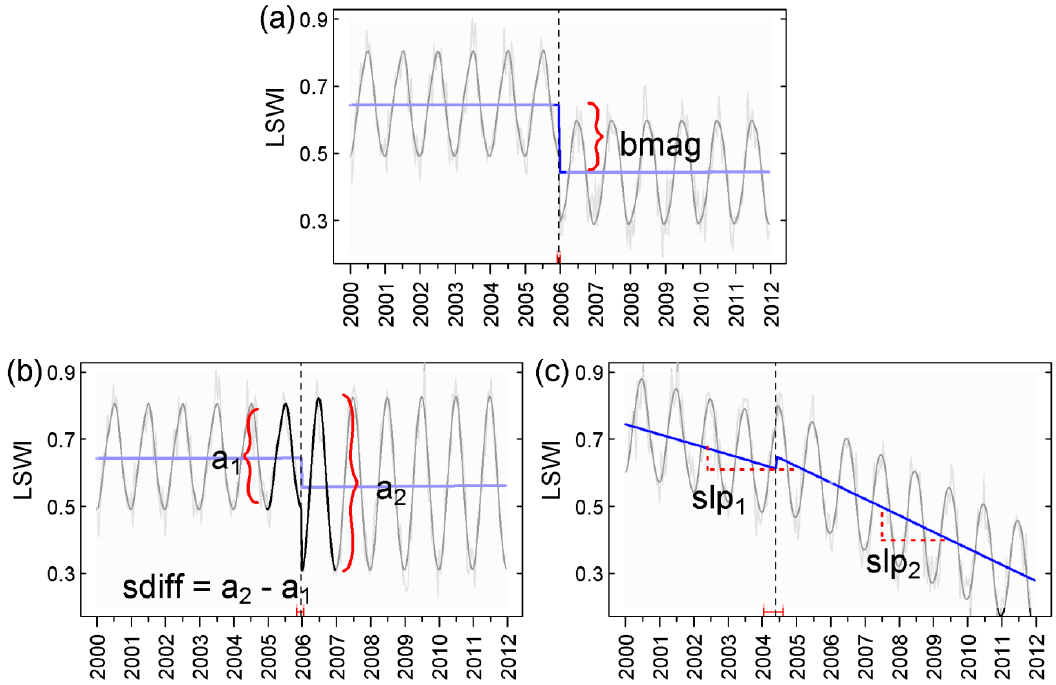
Figure 2. Examples of Breaks For Additive Season and Trend (BFAST) and three change indicator variables. Simulated 16-day composite data with breakpoints at year 2006 were used for this methodological description showing: the break magnitude ( bmag ) ( a ); the seasonal amplitude difference ( sdiff ) ( b ); and the most negative slope ( slp ) of the first (slp 1 ) and second (slp 2 ) trend segment—in the example presented this is slp 2 ( c ).